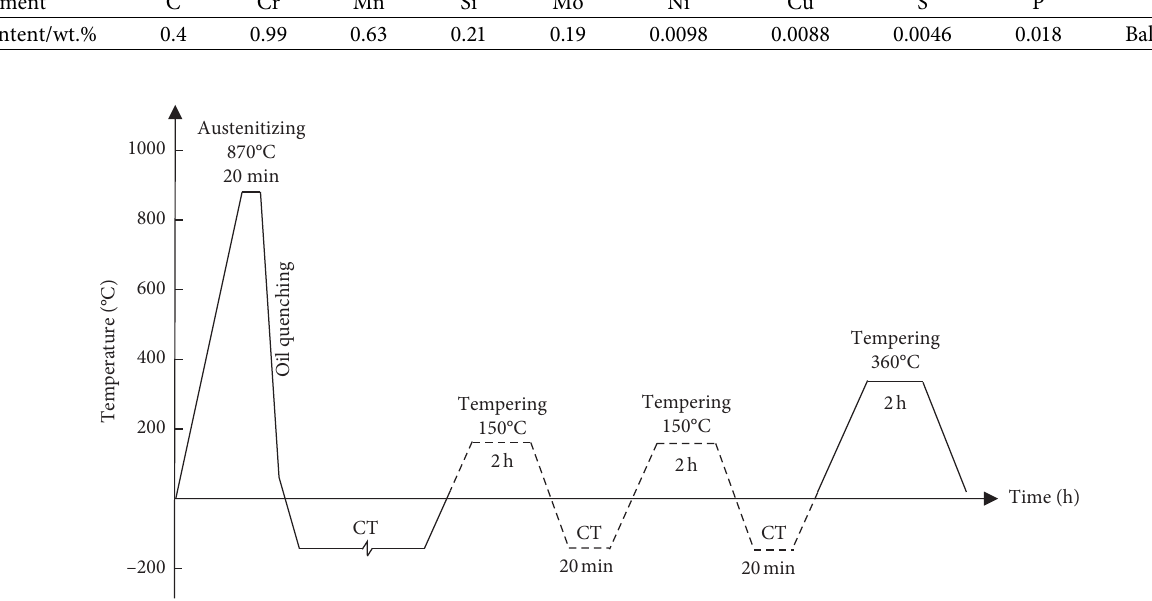
Figure 1: Schematic illustration of the treatment process of 42CrMo steel. Table 2: Levels of factors in cryogenic treatment.